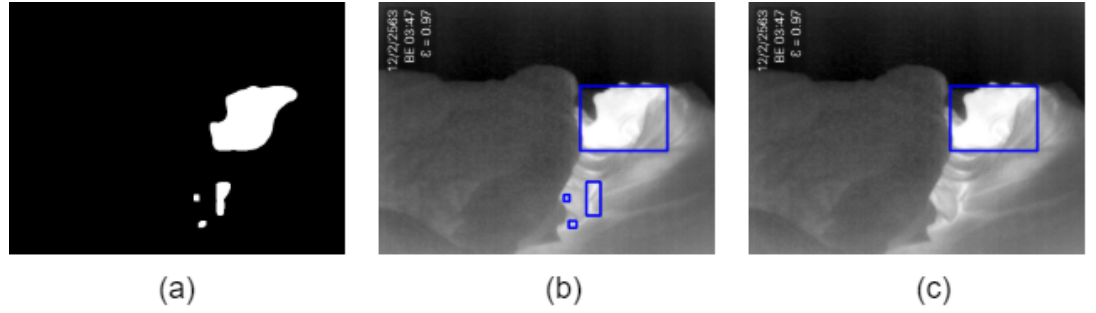
Figure 3. ( a ) All contours, ( b ) bounding rectangles around all contours, and ( c ) bounding rectangle around the most prominent